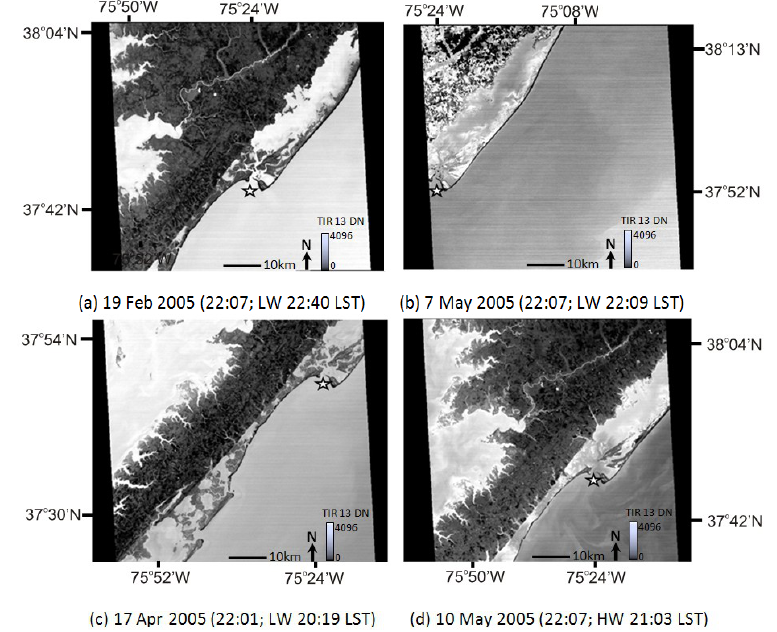
Figure 3. ASTER time series for band 13 thermal Quicklook images (60 km swath) used for image selection and tidal stage analysis. Location of Chincoteague Inlet highlighted (  ). Time of image acquisition and nearest low water (LW) tide or high tide (HW) at Chincoteague Inlet in Local Standard Time (LST) ( a ) 19 February 2005, ( b ) 7 March 2005, ( c ) 17 April 2005, and ( d ) 10 May